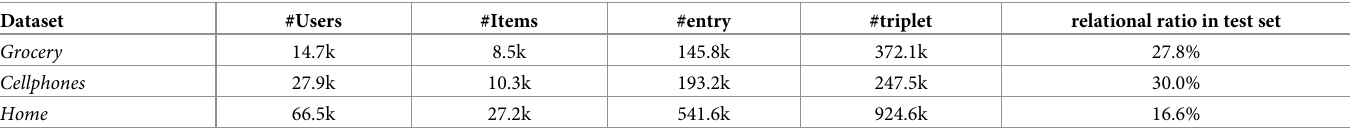
Table 1. Statistics of the